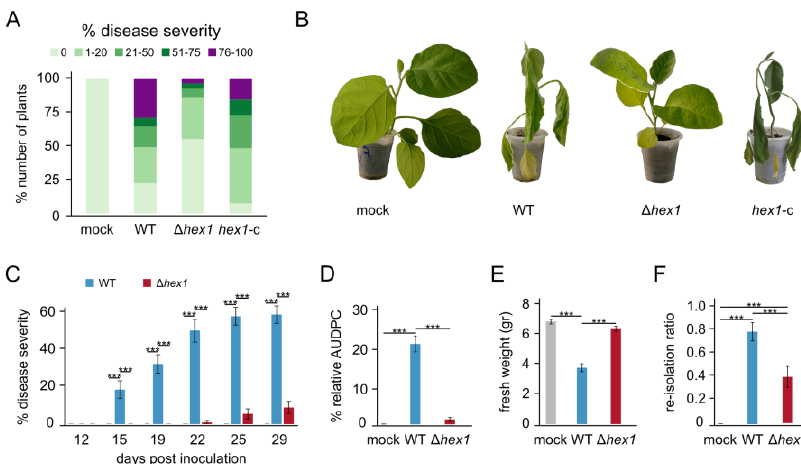
Figure 3. Phytopathological characterization of the V. dahliae Δ hex1 strain. ( A ) Disease severity of the wild-type (WT), the deletion ( Δ hex1 ), and the complemented ( hex1 -c) strains, 45 days post inoculation on eggplant seedlings (30 plants/strain). Uninfected plants (mock) served as control. ( B ) Representative plants are shown for each strain. ( C ) Time-course comparison of disease severity between the wild type and Δ hex1 (21 plants/strain) over 29 days post inoculation. ( D – F ) Mean relative area under disease progress curve (AUDPC) scores, plant fresh weights, and fungal re-isolation ratios at the end of the time-course experiment. Bars = standard error (SE). Statistical testing by one-way ANOVA followed by Tukey’s post hoc test (*** p ≤ 0.001 ).